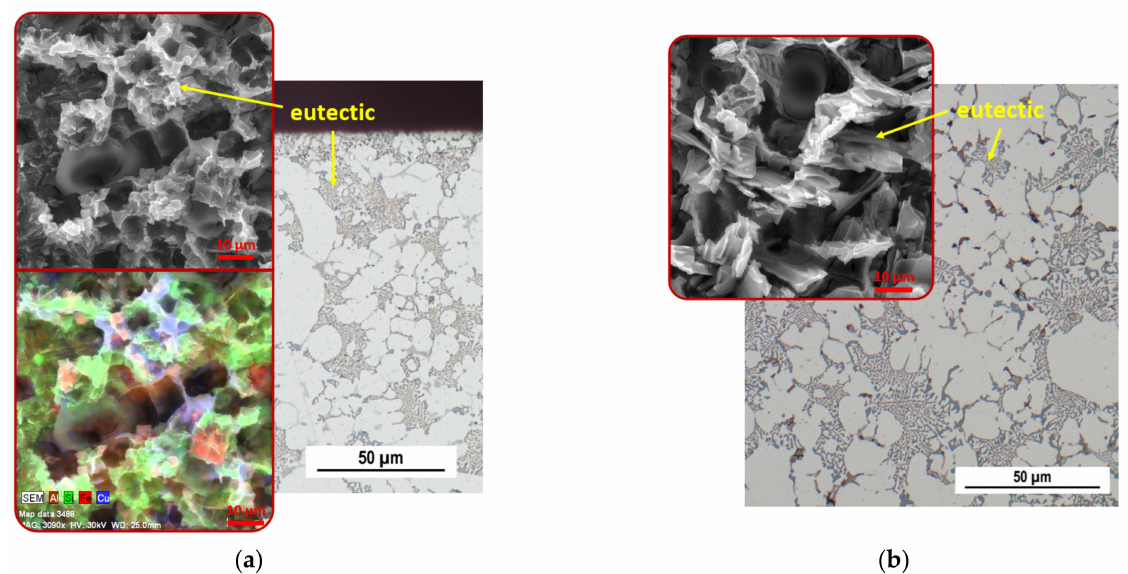
Figure 4. Images of the structure of the Z10 alloy casting in the cast state; OM, SEM: ( a ) surface region; ( b ) central